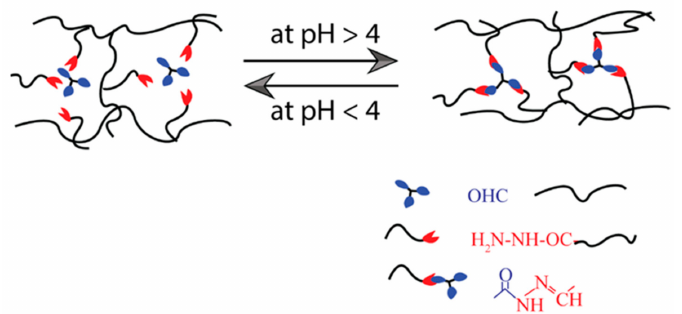
Figure 5. Illustration of self-healing mechanism of pH-dependent Schiff base bond-based